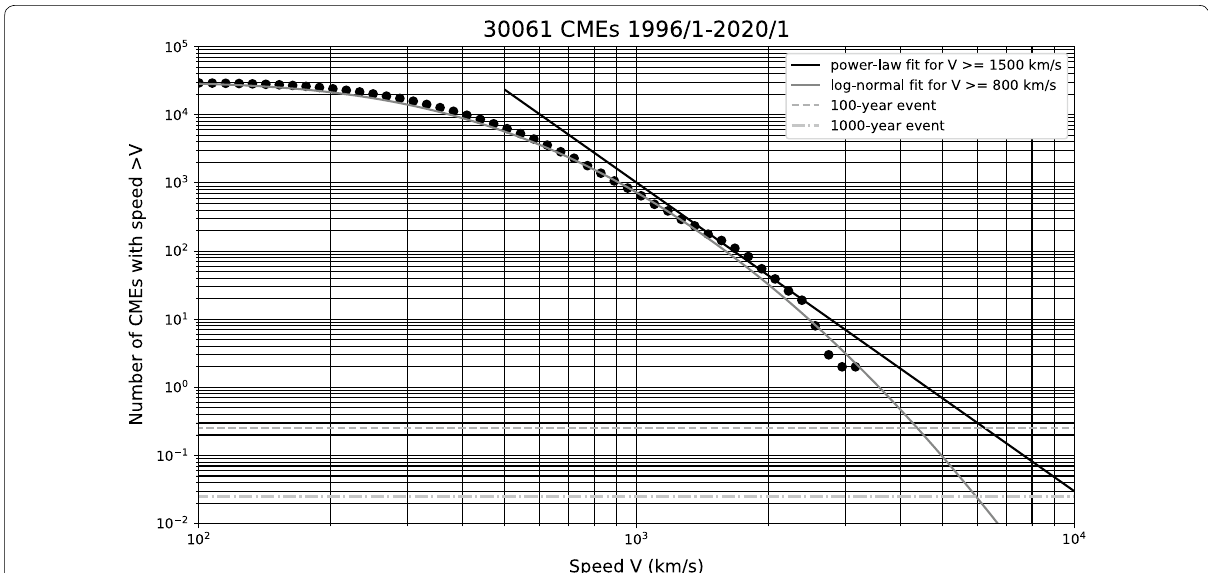
Fig. 7 Cumulative distribution function of CMEs for time interval 1996 to 2020. The data points are displayed at even intervals in logarithmic scale. Log-normal and power-law fits are shown by thick and thin solid curves, respectively. The best fitted parameters are α